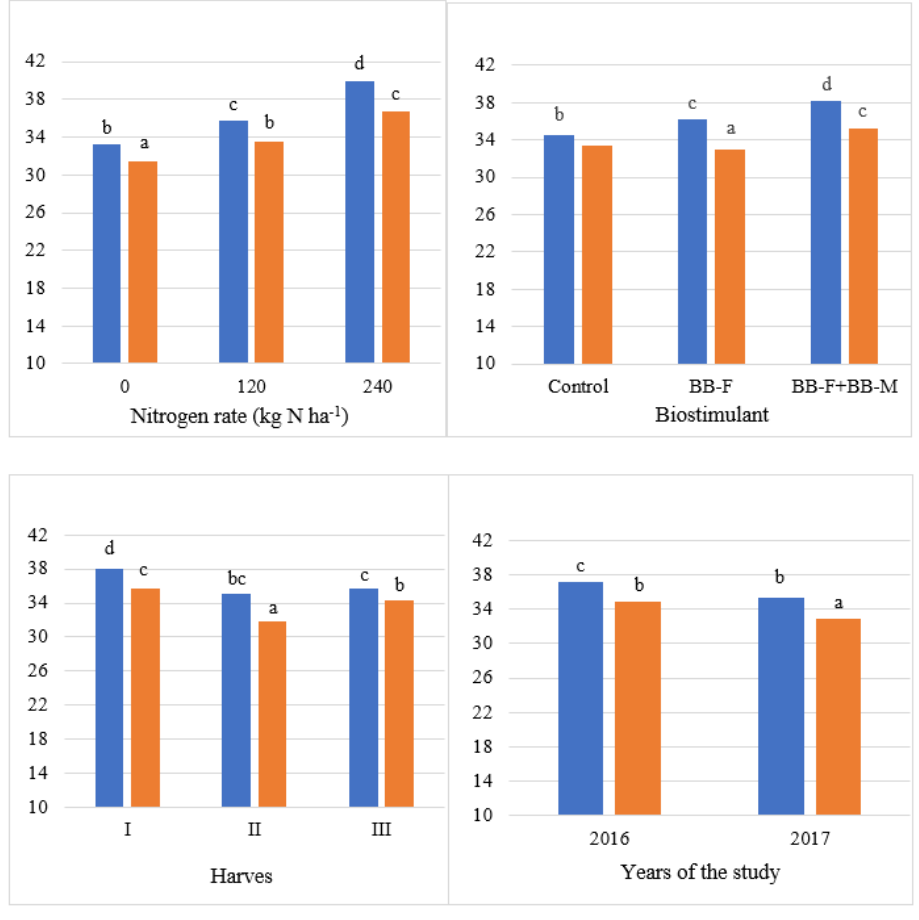
Figure 3. Relationships between the content of chlorophyll (SPAD) in the biomass of the analyzed perennial ryegrass cultivars vs. nitrogen rate, biostimulant and years of the study (the same letter do not differ significantly at p < 0.05 in Tukey’s HSD test).